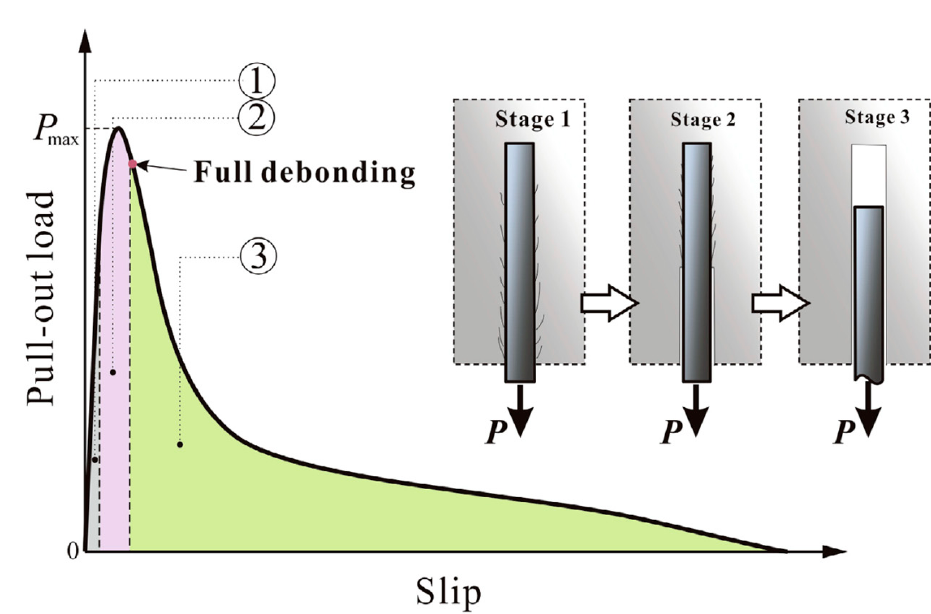
Figure 10. Pull-out test setup for a single fibre [11].